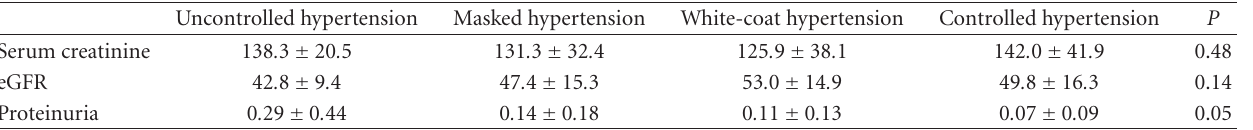
Table 4: Renal associations with